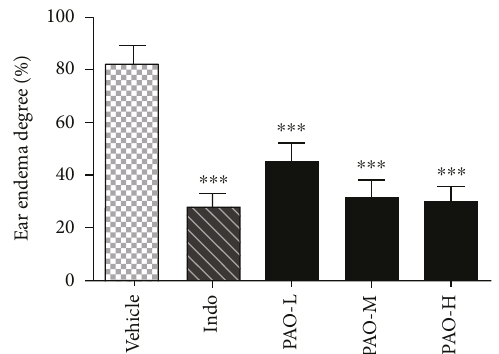
Figure 3: Anti-in fl ammatory e ff ect of PAO on xylene-induced ear edema in mice. Indo: indomethacin (10 mg/kg); PAO-L: low dose of PAO (10 mg/kg); PAO-M: medium dose of PAO (20 mg/kg); PAO-H: high dose of PAO (40 mg/kg). Ear edema degree (%) was represented as the ratio of the di ff erence in weight between the right and left ear of the same animal. Data were expressed as means ± SEM. ( n = 10 ), and ∗∗∗ p < 0 001 versus the vehicle group.